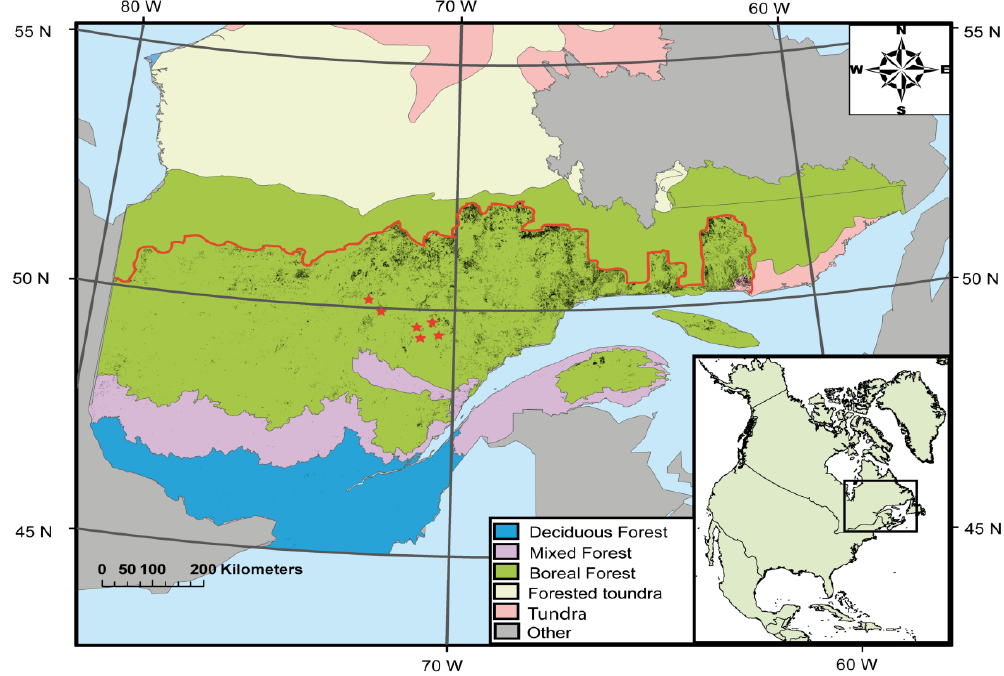
Figure 1. Location of the six study blocks (red star) in Québec, Canada. Small black dots represent all open woodlands, including lichen woodlands, under (red line) the northern limit of timber allocation (Québec Ministry of Natural Ressources 3rd decennial forest